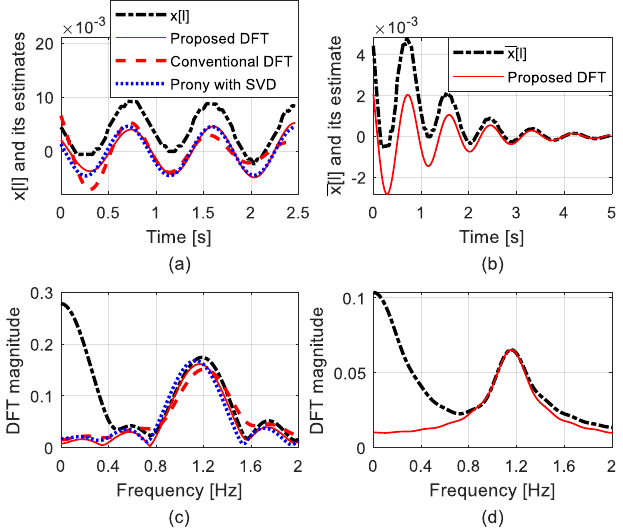
Figure 11. Modal oscillation signal and its estimated signals in the New England power system: ( a ) 𝑥[𝑙] of the first segment and its estimated signals; ( b ) 𝑥 ̅[ 𝑙 ] of the first two combined segments and its estimated signal; ( c ) DFT magnitudes of the signals in (a); ( d ) DFT magnitudes of the signals in ( b ).